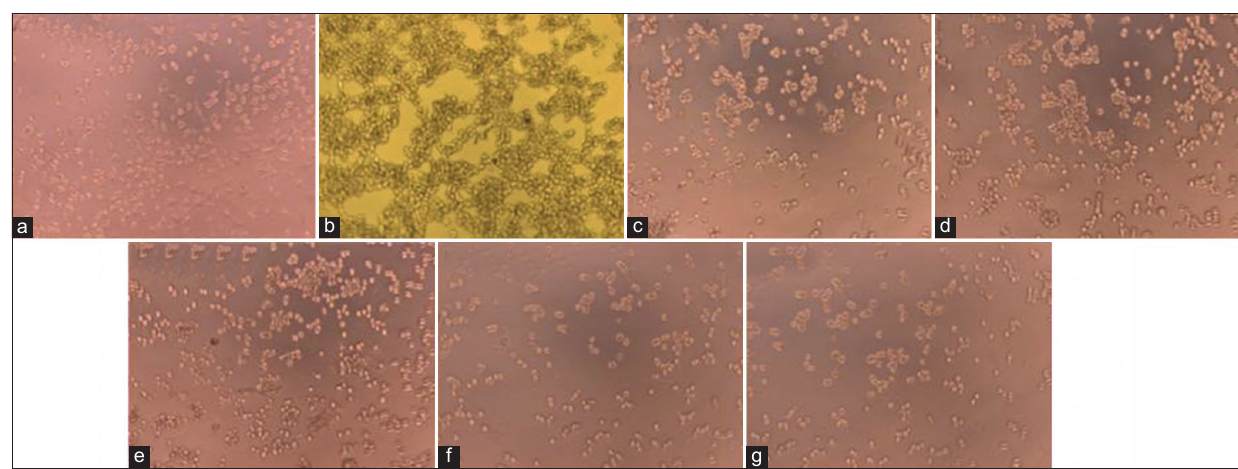
Figure-1: Ocimum sanctum extract inhibits angiogenesis of A549 lung cancer cells. 1×10 5 cells were seeded in each well coated with Matrigel, and the background control wells without Matrigel. Each treatment was added following 30 min of incubation, and the plates were incubated for 18 h at 37°C, 5% CO . (a) Non-treated cells; (b) vascular endothelial 2 growth factor treated cells (20 µ g/mL); (c) Ocimum Sanctum ethanolic extract (OSE) treated cells (50 µ g/mL); (d) OSE treated cells (70 µ g/mL); (e) OSE treated cells (100 µ g/mL); (f) OSE treated cells (200 µ g/mL); (g) cRGD treated cells (20 µ g/mL). Microphotograph taken on